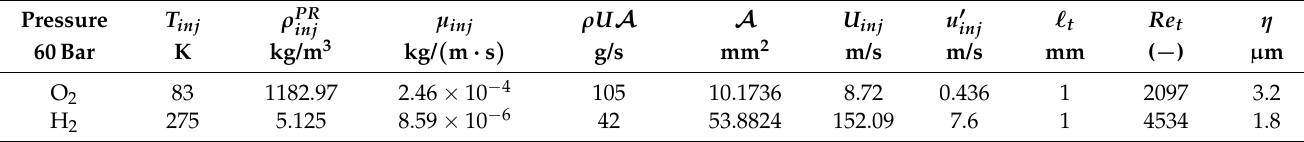
Table 2. Injection data for the two reactants in the MASCOTTE C-60 test case. The density values refer to the Peng–Robinson EoS in its enhanced translated volume formulation (the errors with respect to NIST reference data are 0.35% and 0.52%, respectively, for O 2 and H 2